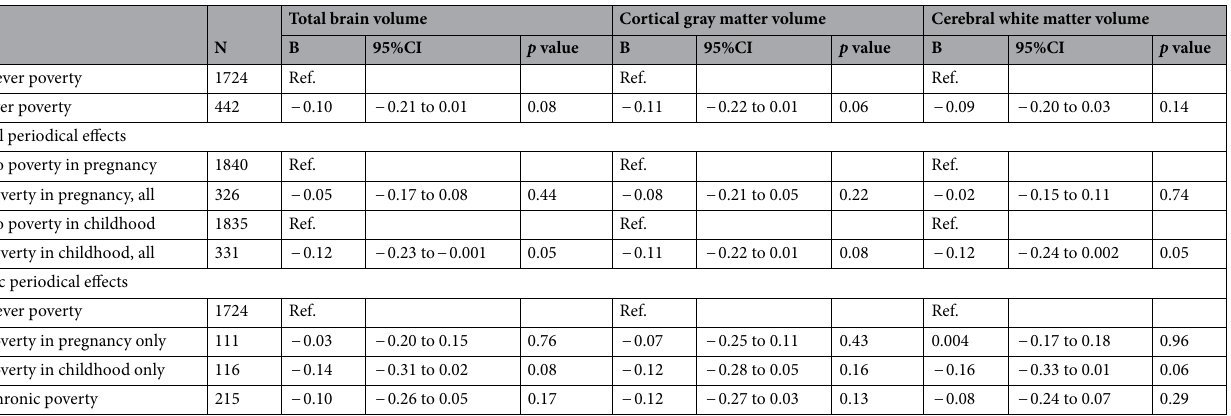
Table 2. The association of poverty with global brain morphology (N = 2166). Models adjusted for child age at brain measurement, child sex, maternal ethnicity, maternal IQ, maternal educational attainment at pregnancy, and maternal and paternal psychiatry symptoms at pregnancy. All brain measures of outcome are standardized. Ever poverty is a total of "poverty in pregnancy only", "poverty in childhood only" and "chronic poverty". There is no p values survived the multiple comparisons corrections (four tests for ever, pragnant any and childhood any poverty and 12 tests (= four brain metrics × three timings of exposure) for pregnant, childhood and chronic poverty) with the Benjamini–Hochberg false discovery rate